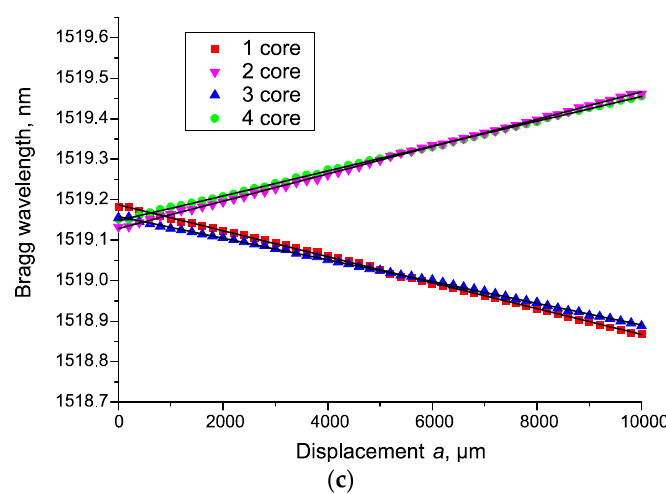
Figure 6. Sensor’s readings depending on the linear deformation a for four channels at: ( a ) θ ≈ − 2.2°; ( b ) θ ≈ 20.1°; ( c ) θ ≈ 41.6°.